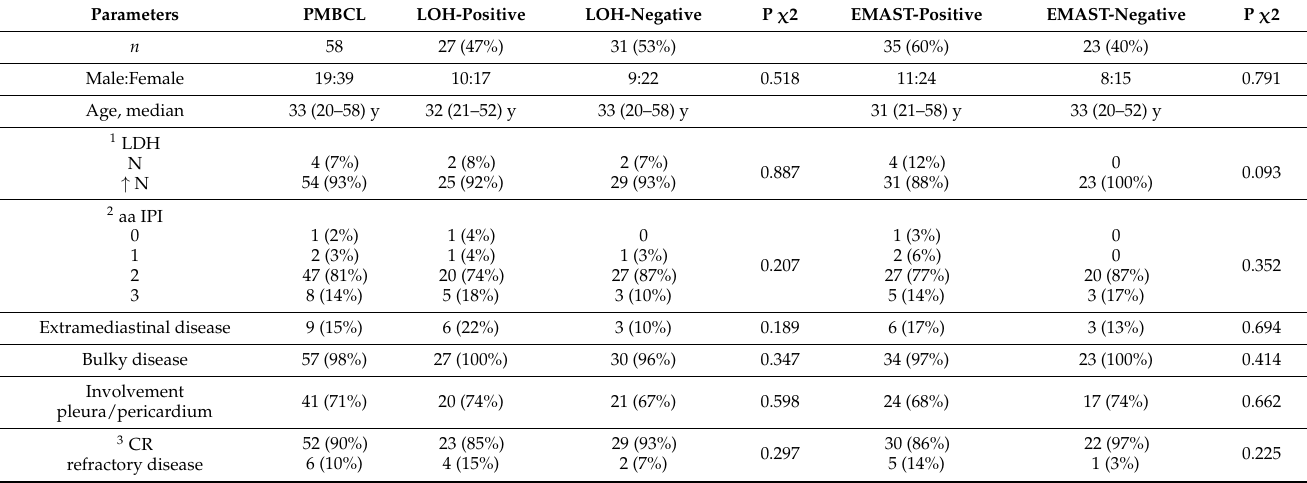
Table 1. The main characteristics of patients receiving R-Da-EPOCH-21 therapy and their LOH and EMAST